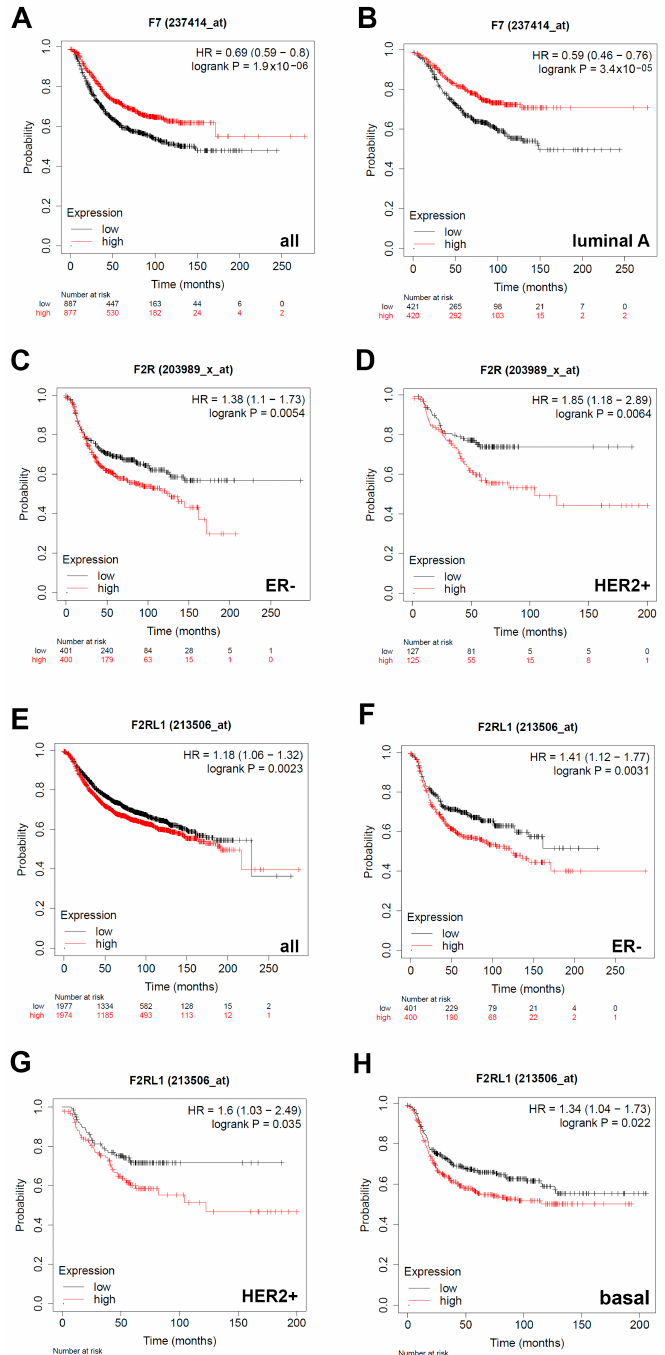
Figure 5. The prognostic value of the expression of F7 (factor VII), F2R (PAR1), and F2RL1 (PAR2) in patients with breast cancer. Kaplan–Meier curves are plotted based on expression of F7 in ( A ) all patients showing F7 expression ( n = 1734), and ( B ) patients with luminal A classification ( n = 841). Expression of F2R in ( C ) ER-classified patients ( n = 801) and ( D ) HER2 + classified patients ( n = 252). Expression of F2RL1 in ( E ) all patients ( n = 3951), ( F ) ER- classified patients ( n = 801), ( G ) HER2 + classified patients ( n = 252), and ( H ) patients with tumors of the basal subtype ( n = 618). Curves were analyzed using the log-rank test. Log-rank p -values and hazard ratios (HRs; 95% confidence interval in parentheses) are shown. The corresponding Affymetrix IDs are: F7: 204363_at; F2R: 203989_x_at; F2RL1: